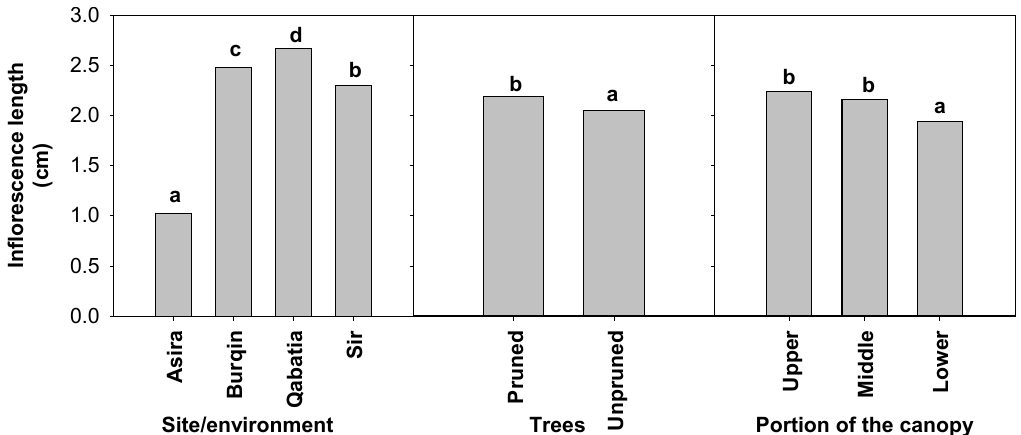
Figure 5. Mean olive inflorescence lengths as influenced by the site/environment, pruning and portion of tree canopy. Means of each factor accompanied by the same letter are not significantly different ( P ≤ 0.05).